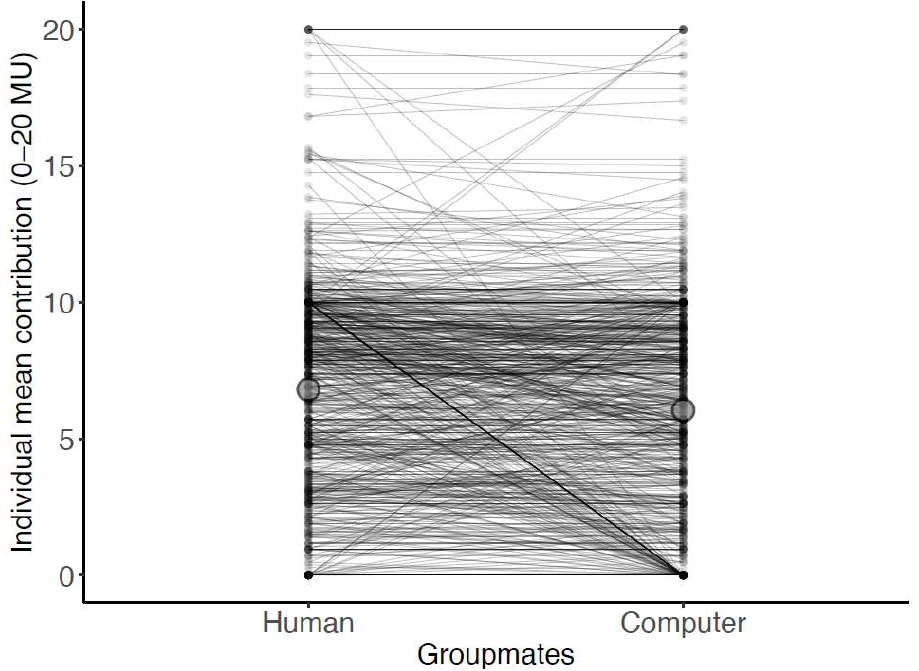
Figure 2. Individual behaviour. Every individual’s mean contribution with either humans or computers ( n = 845). Lines connect individual responses. Larger transparent circle shows the overall mean for each case.